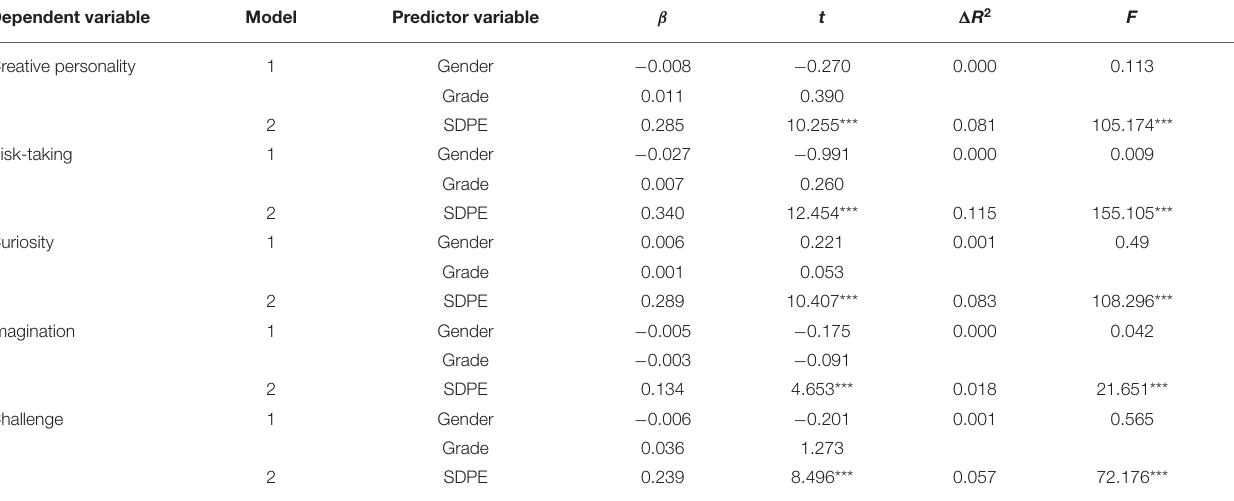
TABLE 2 | Hierarchical regression analysis of creative personality and its dimensions on self-determination in physical exercise. Dependent variable